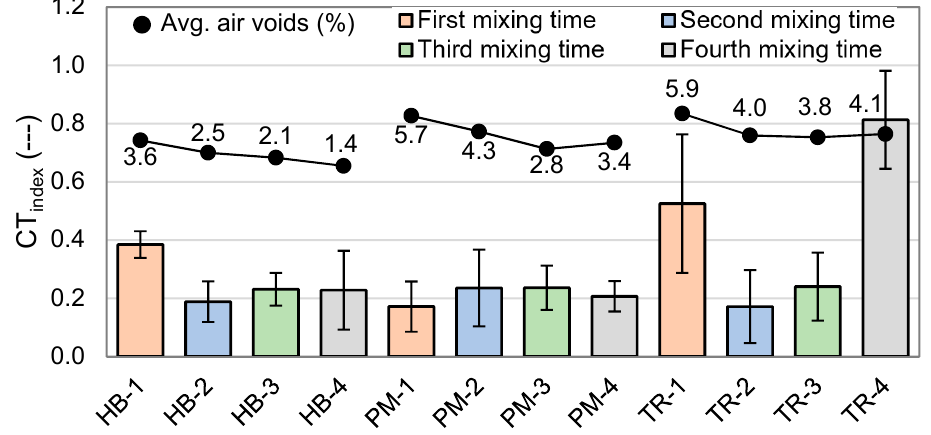
Figure 14. Crack tolerance index (CT index ) results at − 20 °C ( n = 3).